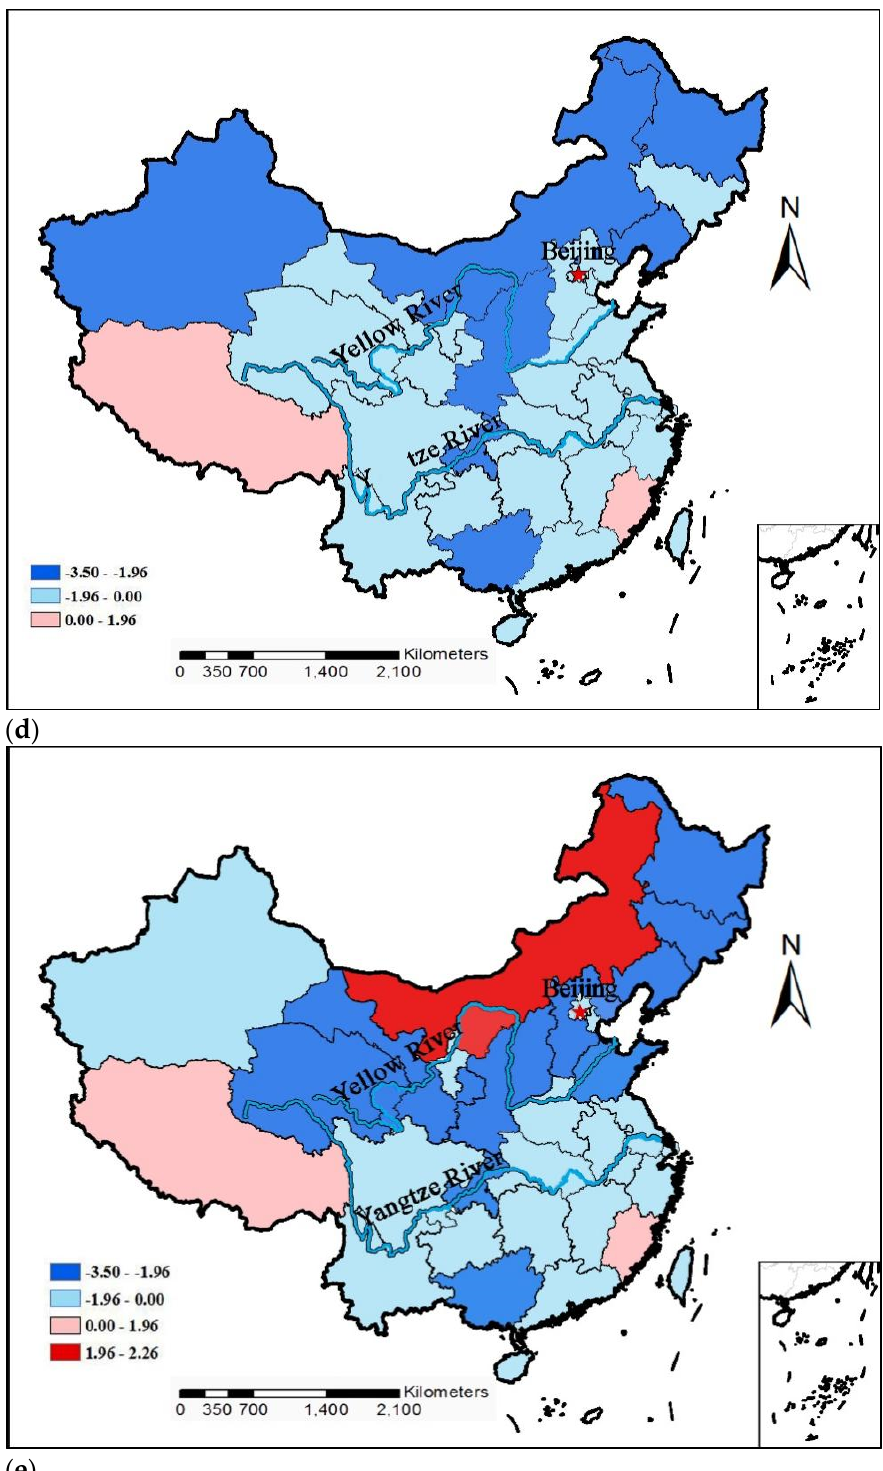
Figure 6. Z-value of the national disaster data over the past 12 years: ( a ) crop damage area; ( b ) crop area with drought disaster; ( c ) total crop failure area; ( d ) number of people with reduced drinking water owing to drought; ( e ) number of domestic animals with reduced drinking water caused by drought.